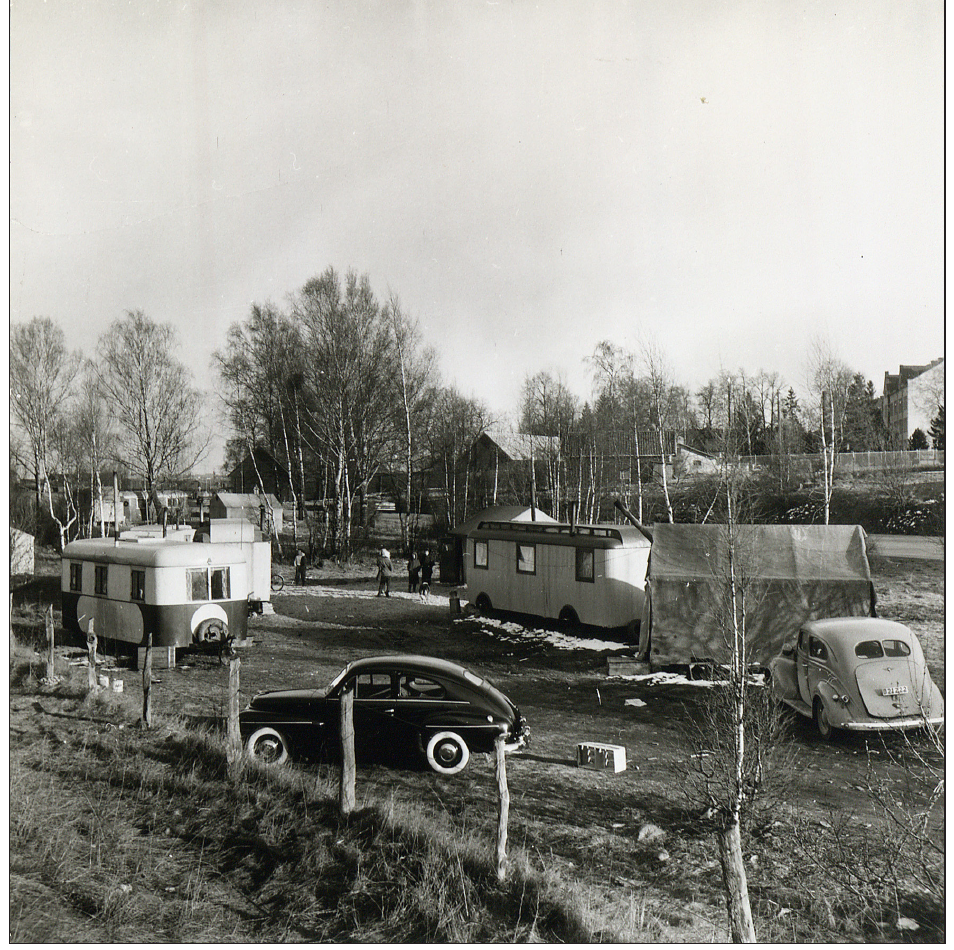
Figure 1: A Roma camp in Norrköping, Sweden, in the 1950s. (Photo: Carl-Herman Tillhagen, in Sveriges zigenare vol. 1–5, Nordiska